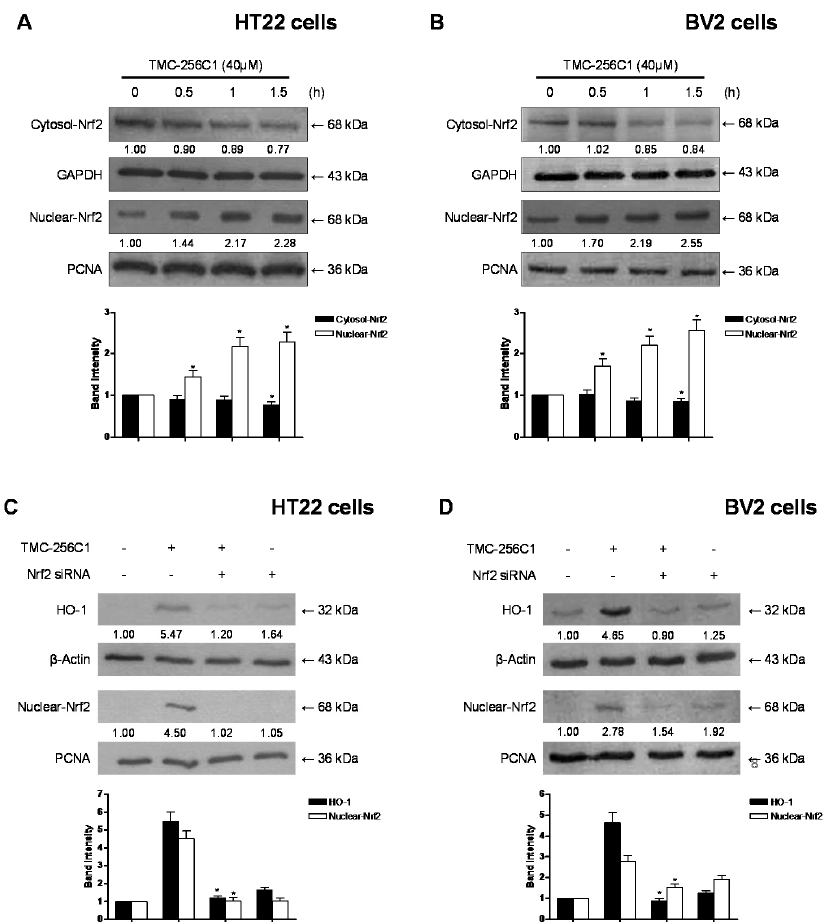
Figure 8. Effects of TMC-256C1 on the nuclear translocation of nuclear transcription factor-E2-related factor 2 (Nrf2) ( A , B ) and Nrf2-mediated HO-1 ( C , D ) in HT22 cells and BV2 cells. Cells were treated with 40 µ M of TMC-256C1 for 0.5, 1, and 1.5 h ( A , B ). The nuclei were fractionated from the cytosol using M-PER™ Mammalian Protein Extraction buffer (Pierce Biotechnology, Rockford, IL, USA). HT22 cells and BV2 cells were transiently transfected with Nrf2 siRNA and then treated with 40 µ M TMC-256C1 for 12 h ( C , D ). Nrf2 protein was detected by Western blot analysis and representative blots of three independent experiments are shown. Band intensity was quantified by densitometry and normalized to β -actin, glyceraldehyde-3-phosphate dehydrogenase (GAPDH) and proliferating cell nuclear antigen (PCNA), and the normalized values are presented at the bottom of each band. The data shown, representative of three independent experiments, are the mean values of three experiments ˘ SD. * p < 0.05 compared to the group treated with